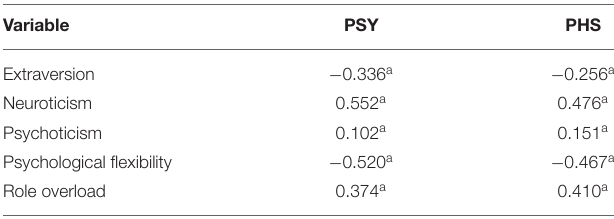
TABLE 2 | Relationship between role overload, personality, psychological flexibility, and stress. Variable